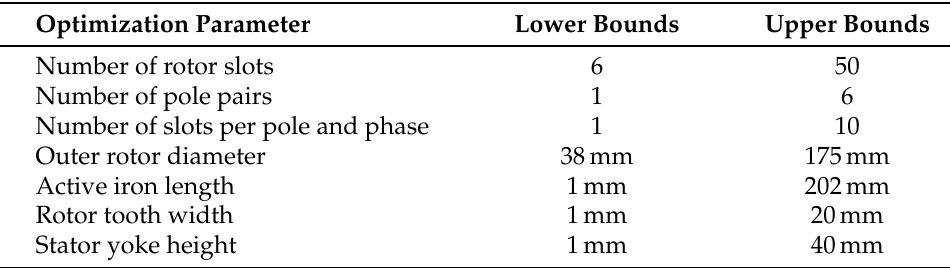
Table 4. Optimization parameters with associated lower and upper